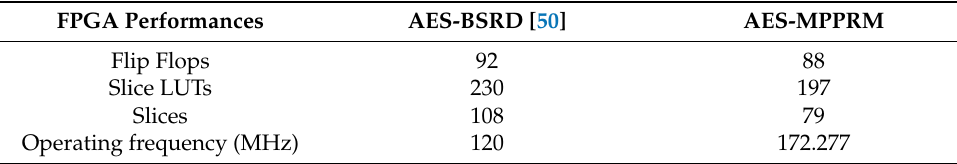
Table 10. Comparison of AES-MPPRM and AES-BSRD for Spartan 6 FPGA.